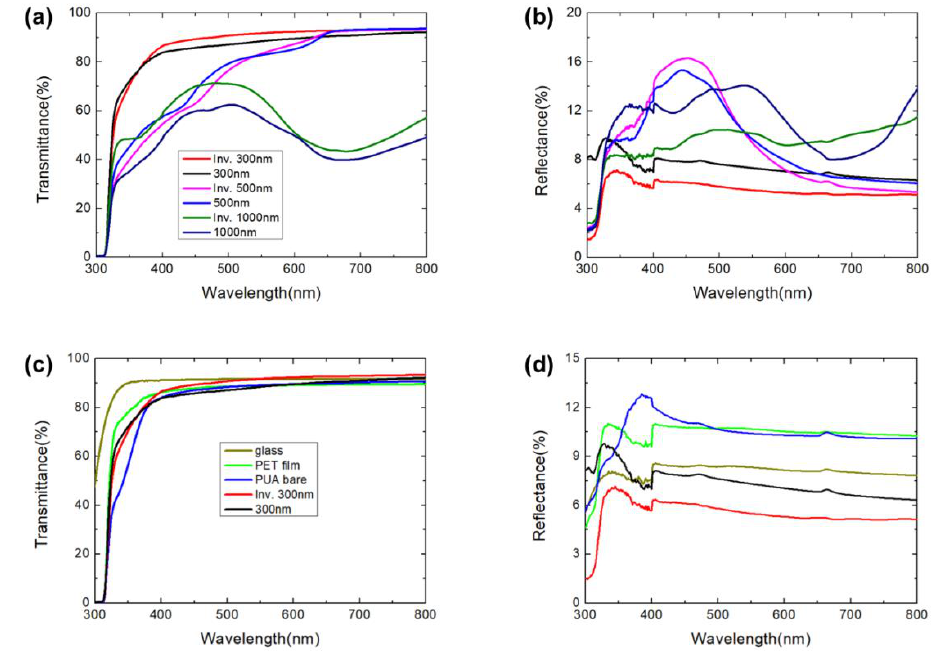
Figure 3. ( a ) Transmittance and ( b ) reflectance of MPS and IMPS with six different samples. Comparison of ( c ) transmittance and ( d ) reflectance with glass, PET film, PUA bare and MPS/IMPS samples with pitches of 300 nm.